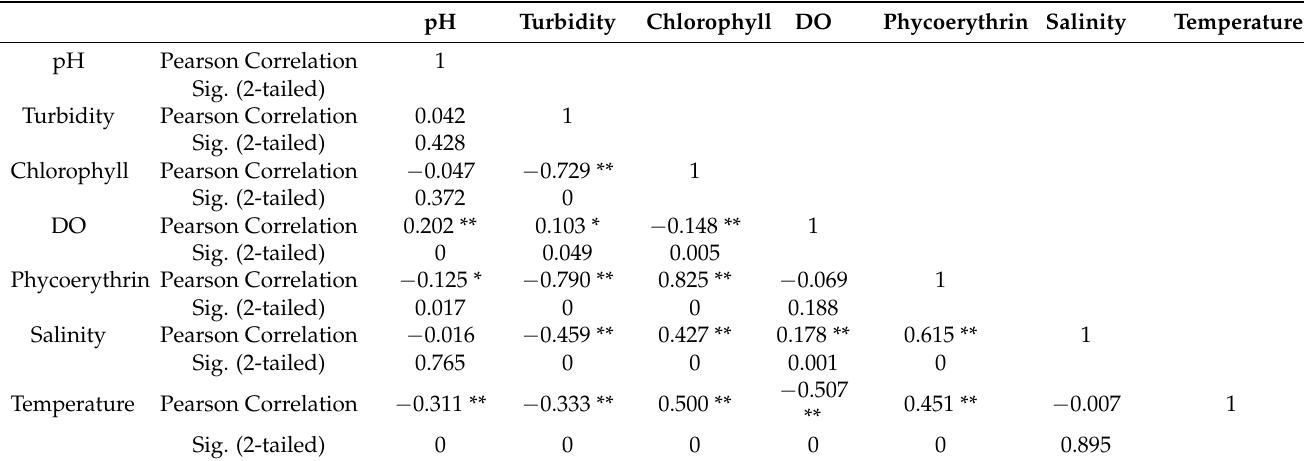
Table 8. Pearson correlation matrix based on HT